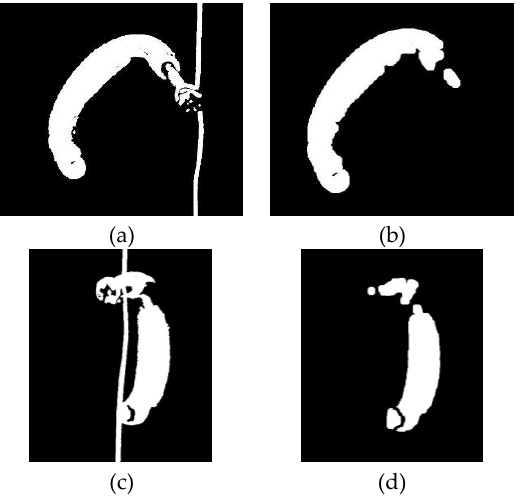
Figure 6. ( a ) Item A, fragmented after thresholding; ( b ) item A, after morphological opening; ( c ) item B, thinned after thresholding; ( d ) item B, fragmented after morphological opening.